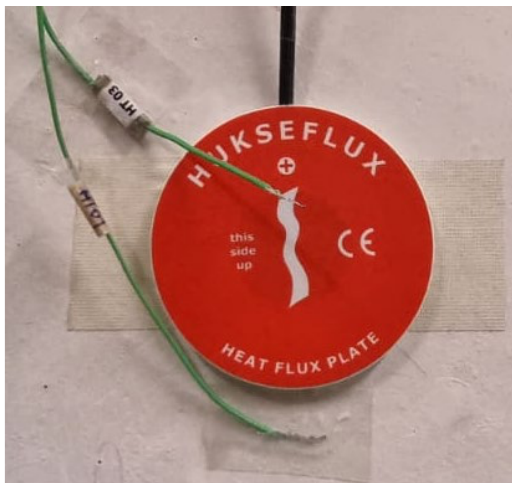
Figure 7. Thermocouple and heat flux meter setup.